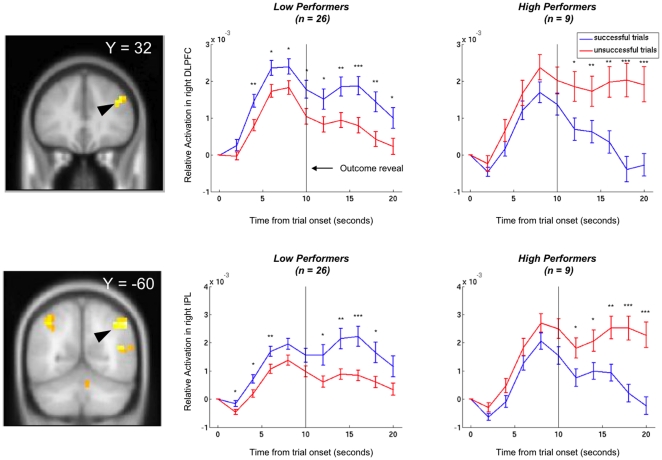
Significant interactions between response to success vs. failure and performance.
A: Coronal slice shows dorsolateral prefrontal region with different responses to treatment success vs. failure in high vs. low performing subjects (left). Region-of-interest plots show timeseries of relative activation in the area on successful (blue) and unsuccessful (red) trials for high and low performing subjects (right). B: Coronal slice shows differential responses to success and failure in the in the inferior parietal lobule (IPL). Region-of-interest plots show timeseries of activation in the right IPL on successful (blue) and unsuccessful (red) trials for high- and low-performing subjects. Timeseries error bars indicate standard error. Significant differences at each timepoint are marked for p<0.05 (*), p<0.01 (**), and p<0.001 (***) in a 2-sample t-test. Note that timeseries are time-locked to scenario presentation time.